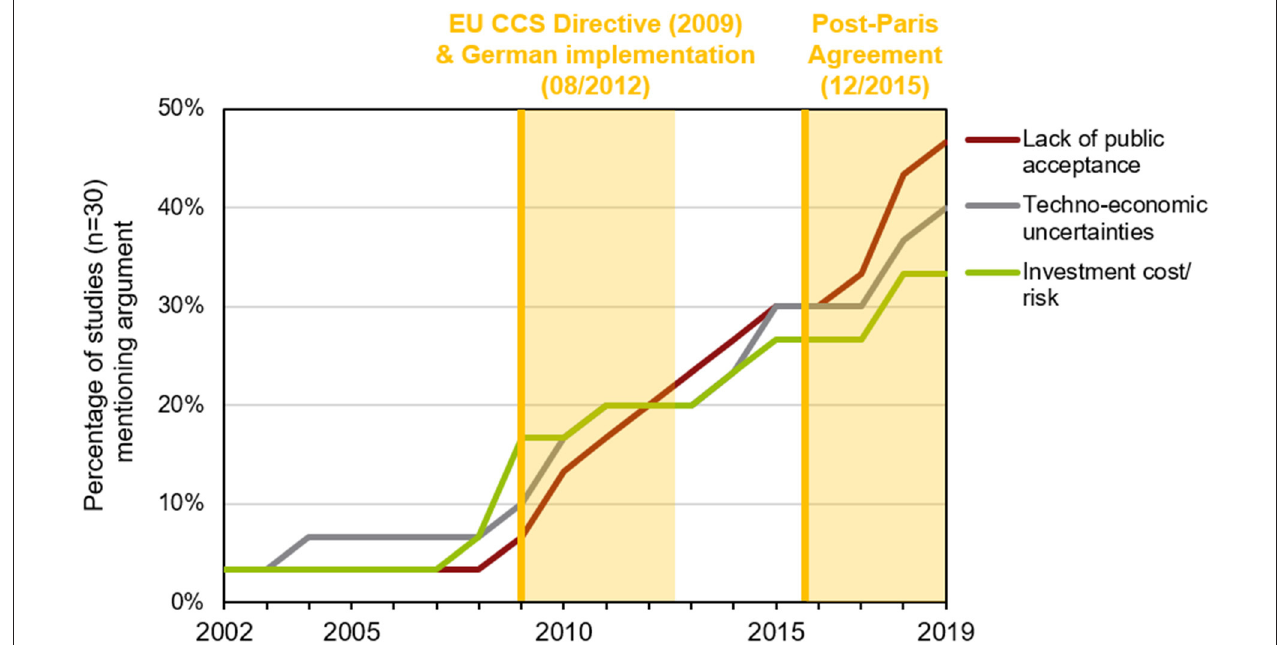
FIGURE 6 | Most frequently mentioned obstacles to (BE)CCS deployment in